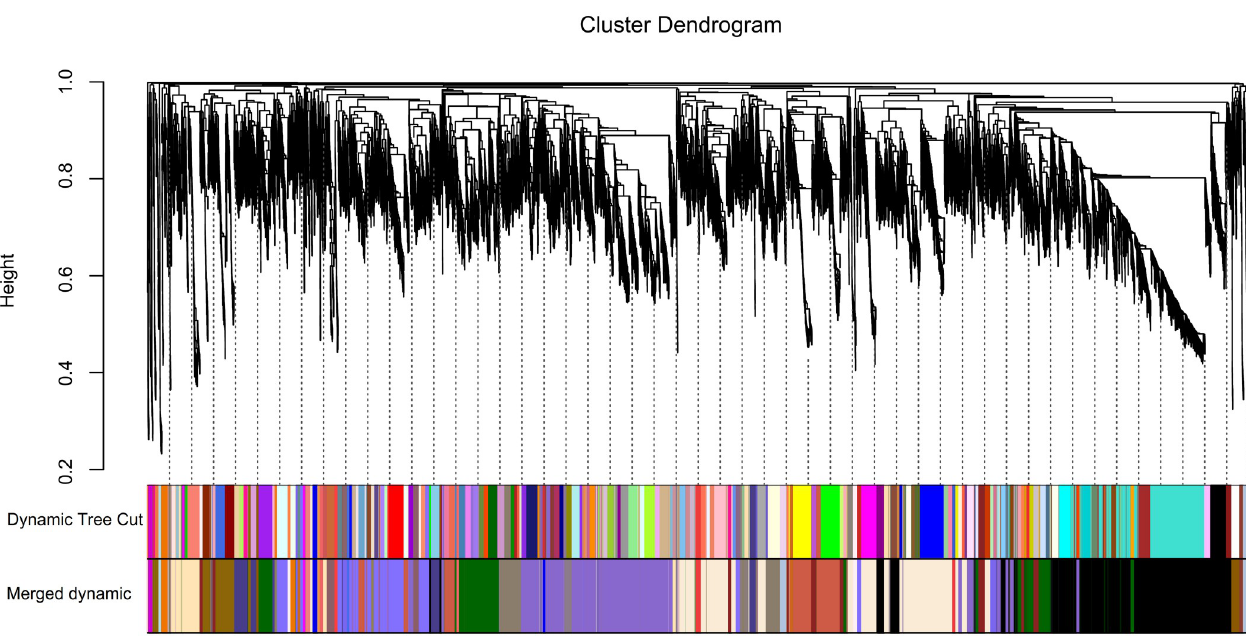
Fig 4. Clustering of genes and modules. The cluster dendrogram at the top of the plot shows co-expressed genes. The branches and color bands at the bottom of the plot represent the assigned